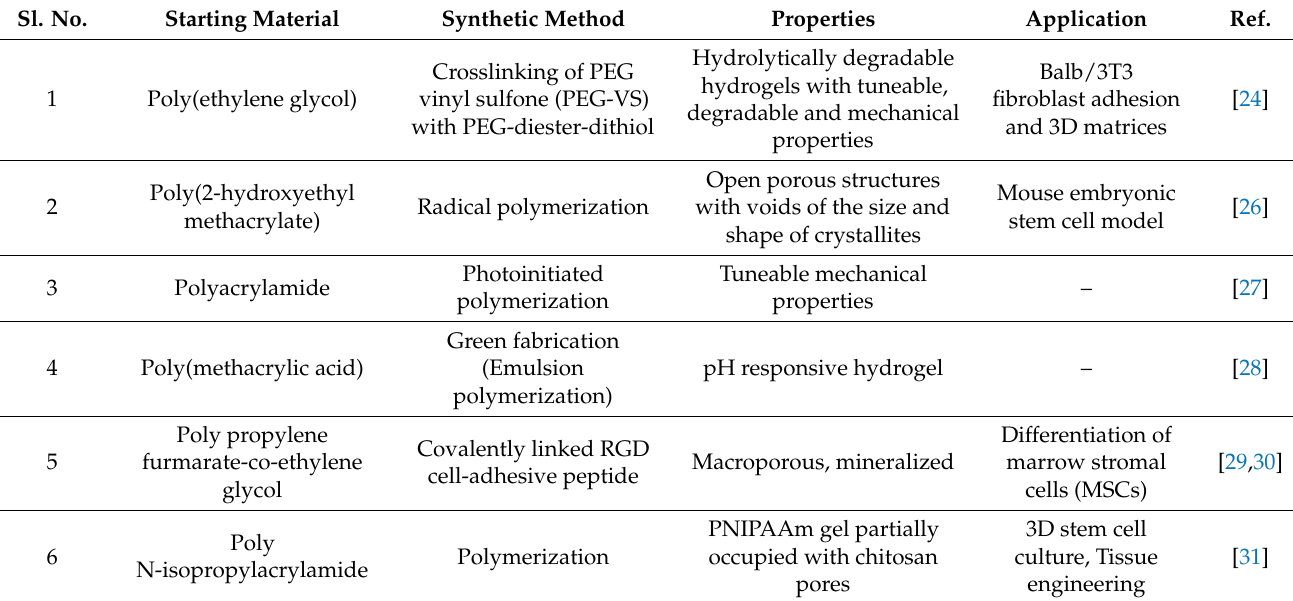
Table 2. Recently reported advanced synthetic